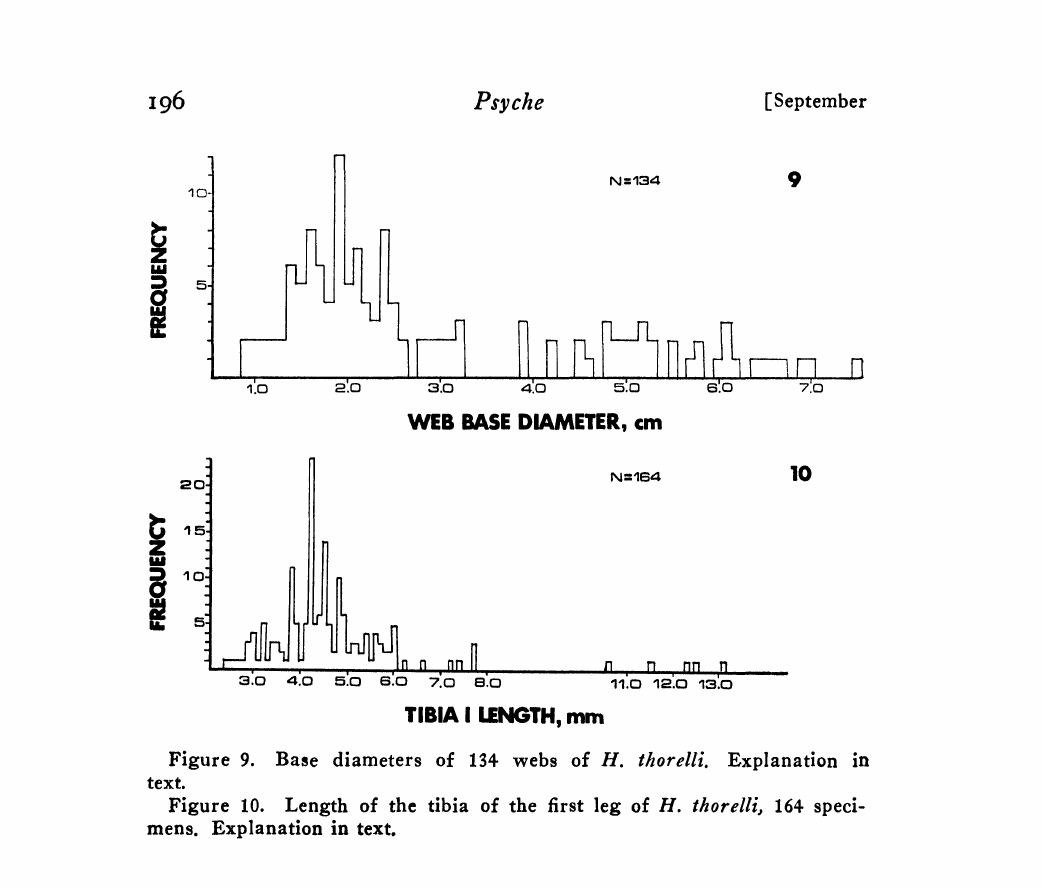
Figure 9. Base diameters of 134 webs of H. thorelli. Explanation in text. Figure 10. Length of the tibia of the first leg of H. thorelli, 164 speci- mens. Explanation in